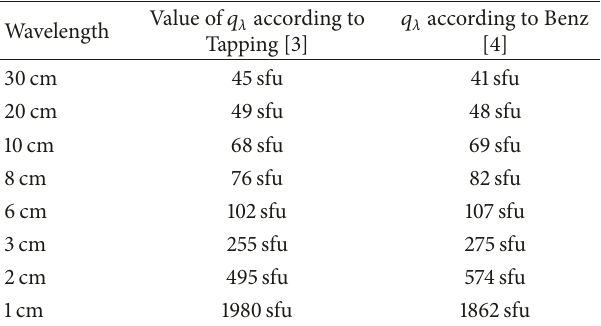
Table 1: Estimate of the quiet solar flux density 𝑞 𝜆 at various